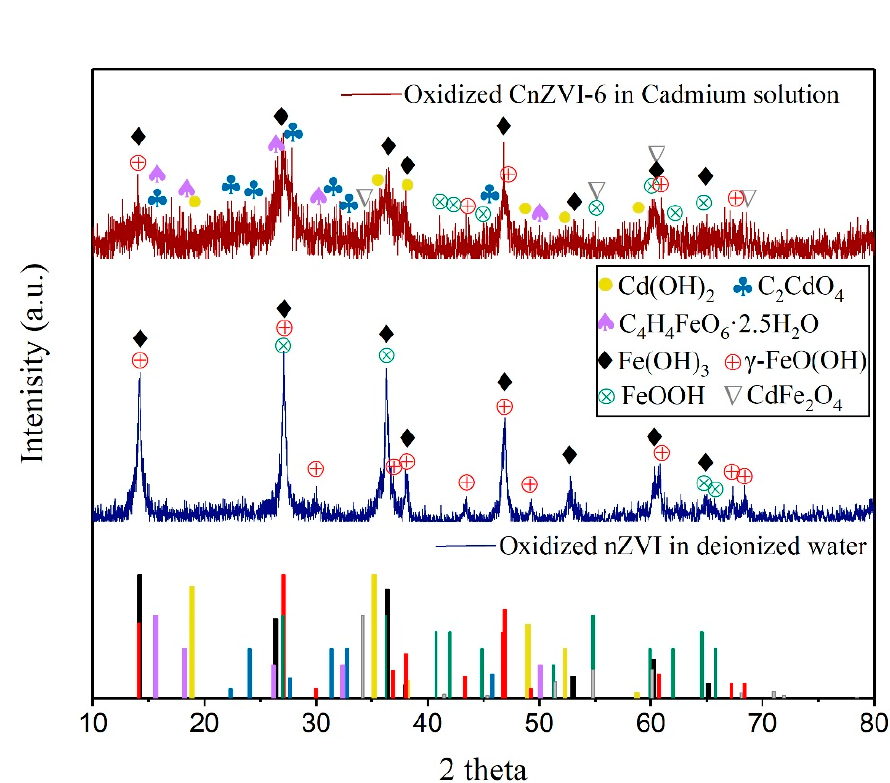
Figure 3. XRD analysis of the composition evolution of the bare nZVI in deionized water (blue line) and CnZVI-6 particles in cadmium solution (red line).